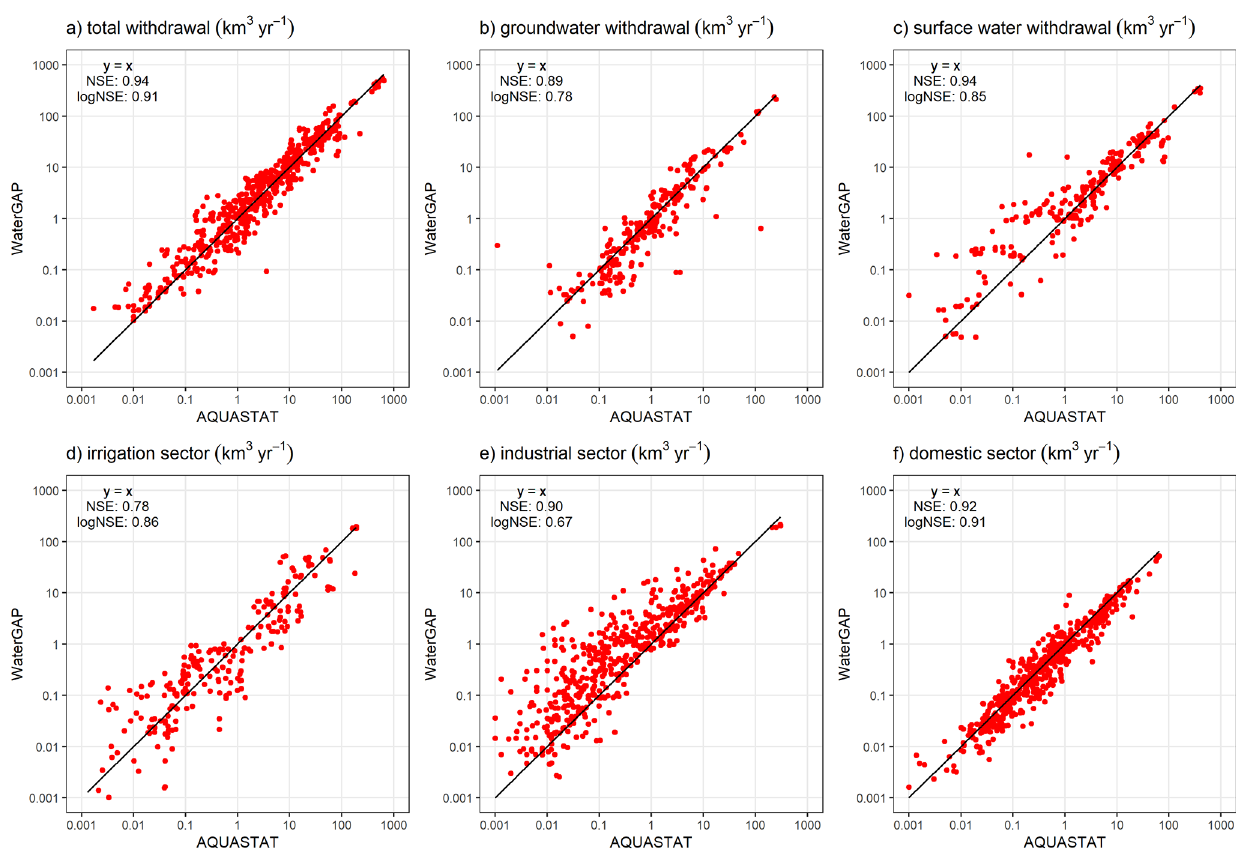
Figure 5. Comparison of potential withdrawal water uses from WaterGAP 2.2d with AQUASTAT (FAO, 2019). Each data point represents one yearly value (if present in the database) per country for the time span